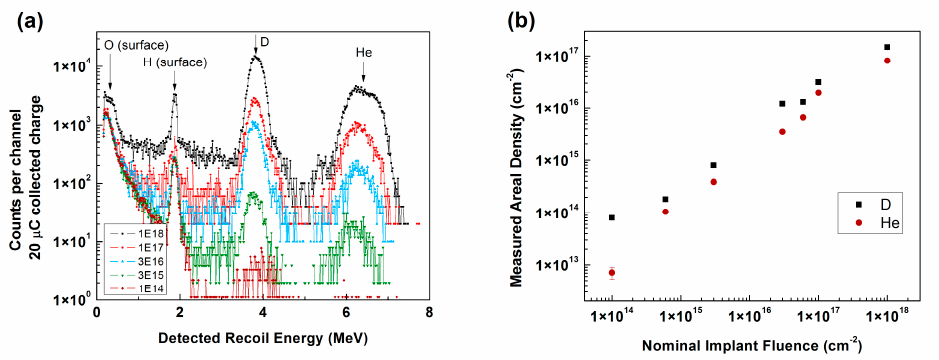
Figure 2. Elastic recoil detection (ERD) results from He + D implantations into Si wafers, showing labeled peaks for select fluences in ( a ) and the measured areal density as a function of ion implantation fluence in ( b ). Most error bars are smaller than the data points in ( b ). Note that the scales are log (vertical) in ( a ) and log-log in ( b ).